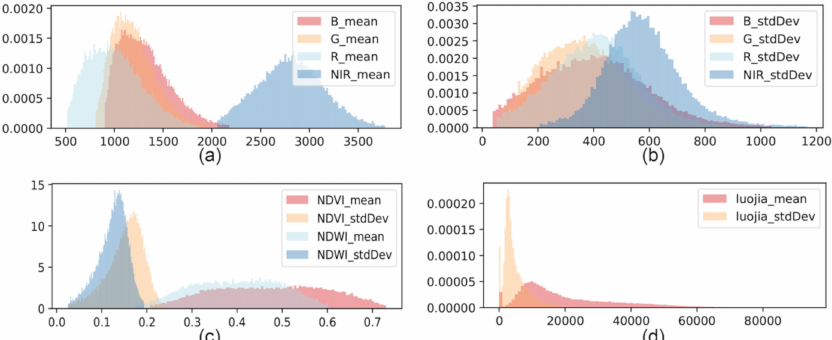
Figure 7. Histograms of features in remotely sensed data. The x-axis represents the value of features. The y-axis represents the probability density. The total number of bins for each graph is 100. Data less than the 1st quartile and greater than the 99th quartile are not shown. ( a ) Histograms of Mean of B, G, R, and NIR bands. ( b ) Histograms of the standard deviation of B, G, R, and NIR bands. ( c ) Histograms of features of NDVI and NDWI index. ( d ) Histograms of features of luojia nighttime light